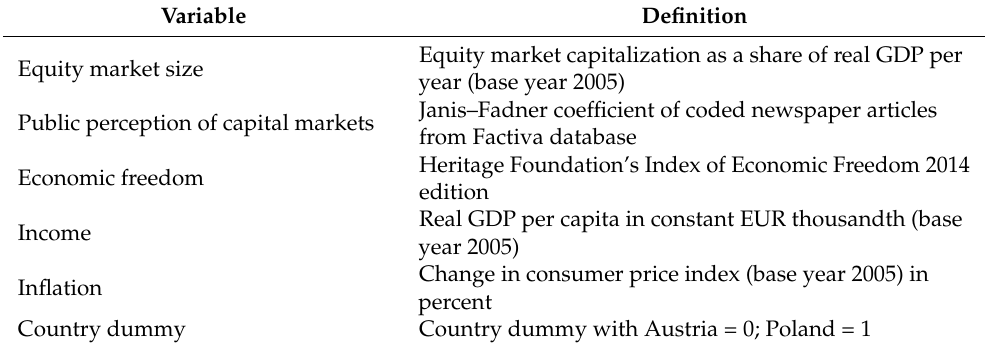
Table 1. Variable